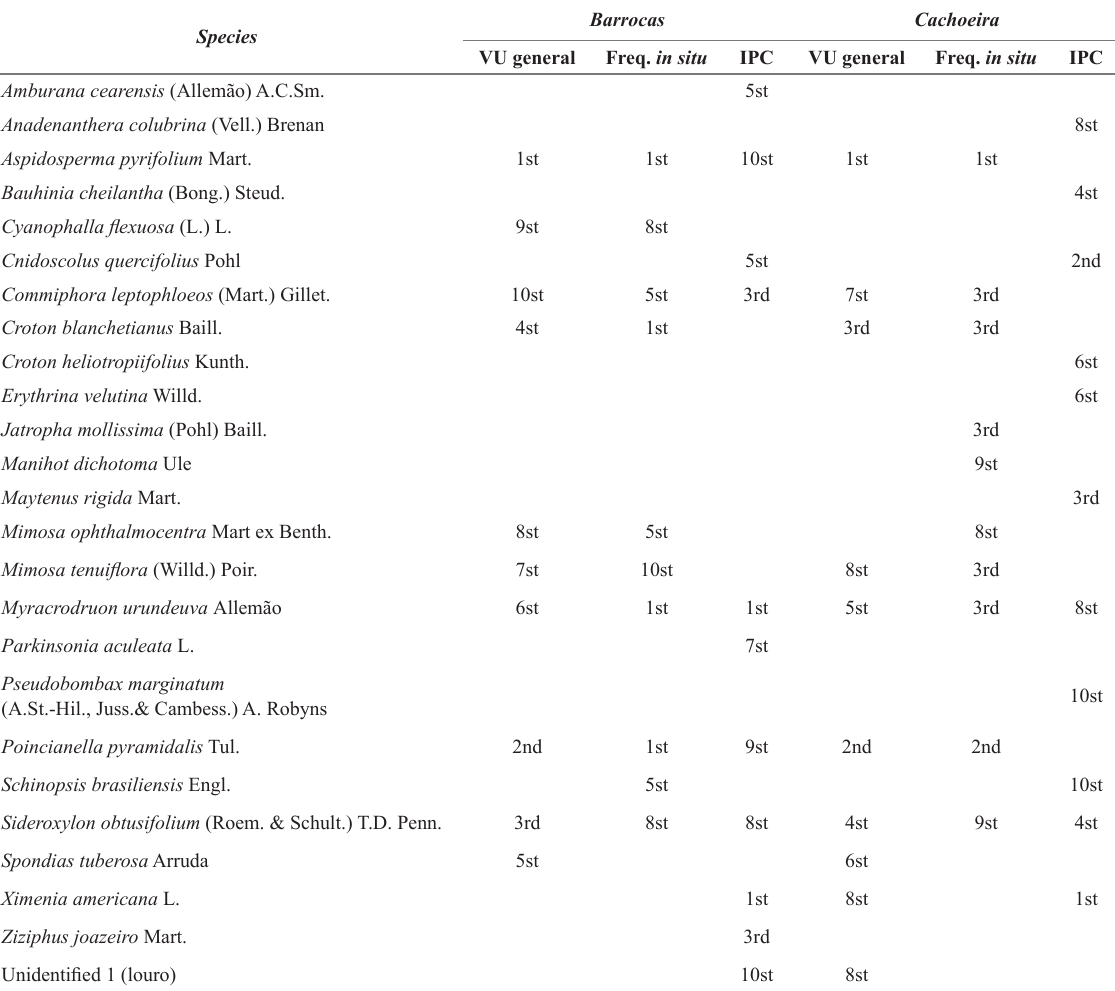
Ranking of the ten species of greater local importance, the second highest use value (VU), the frequency in inventory in situ and conservation priority index (IPC) in the communities